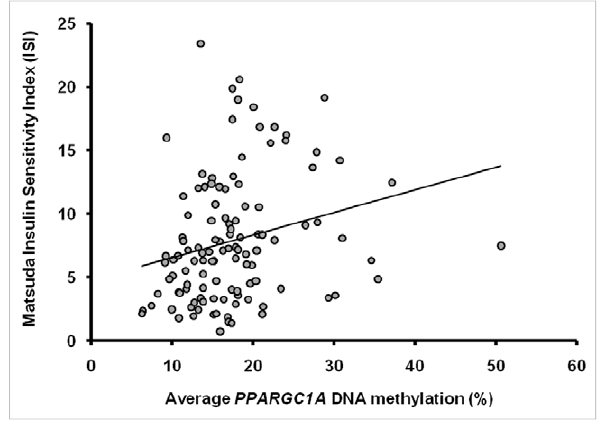
Figure 4. Correlation between average skeletal muscle DNA methylation of the PPARGC1A promoter and whole-body insulin sensitivity. Methylation is shown in percentage and Matsuda ISI was used as a marker of whole-body insulin sensitivity in the FDR group. b =0.12 (0.01;0.24) P =0.03, adjusted for age, gender, BMI, glucose tolerance and family pedigree. Unadjusted correlation (Spear- man’s correlation): r 0.31, P =0.0007.